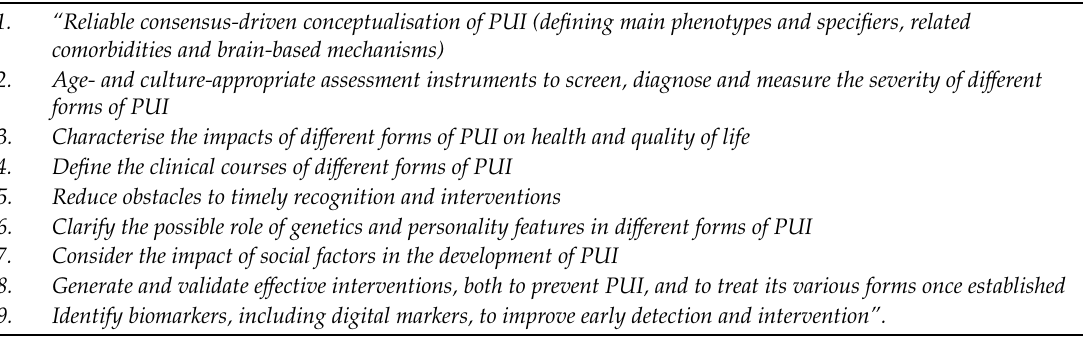
Table 1. Summary of key research priorities to advance the understanding of PUI